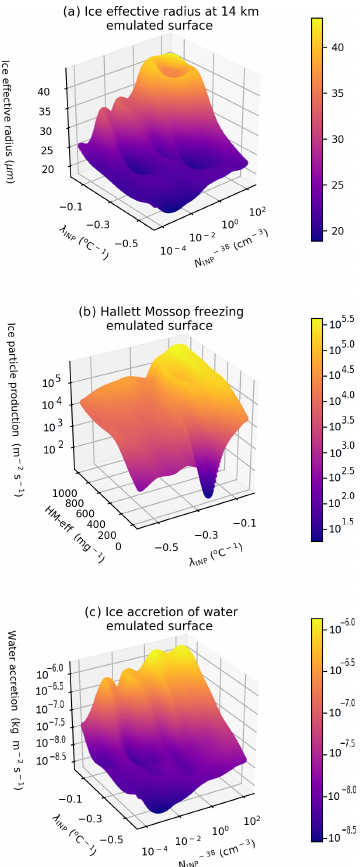
Figure A1. Emulator response surfaces. Prediction of ice effective radius (a) , Hallett–Mossop ice particle production (b) , and accre- tion of water by ice (c) by the emulator. Shown in panels (a) and (c) are the emulated response surfaces at a fixed HM-eff of 350 splin- ters produced per milligram of rimed liquid. Shown in panel (b) is the emulated response surface at a fixed N INP − 38 of 1cm − 3 . The colours indicate output values and are the same range and units as the z axis. Panel (a) is the average of the cloud property between 150 and 240min (anvil stage) of the simulation, while panels (b) and (c) are the average of the relevant cloud property between 60 and 180min (convective stage) of the simulation.